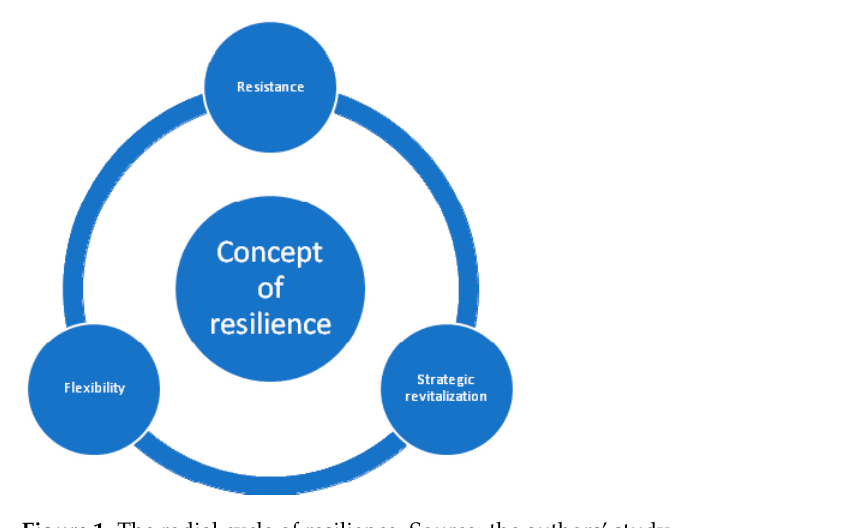
Figure 1. The radial cycle of resilience. Source: the authors’ study.